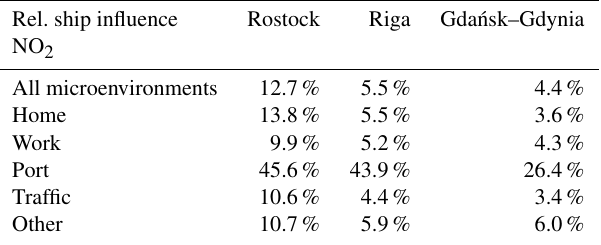
Table 5. Total annual averaged grid mean exposure to NO 2 due to shipping emissions in different microenvironments relative to the total annual averaged grid mean exposure to NO 2 from all